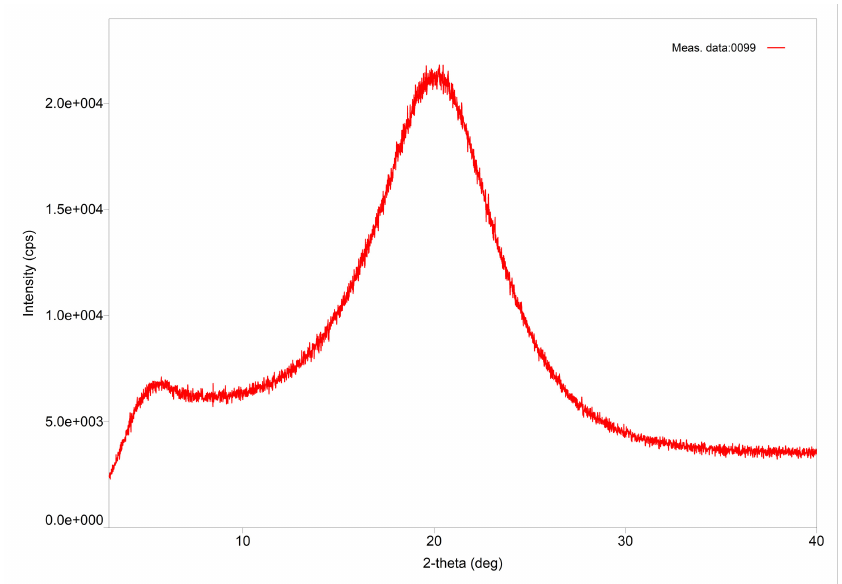
Figure S6: XRPD pattern for polysorbate